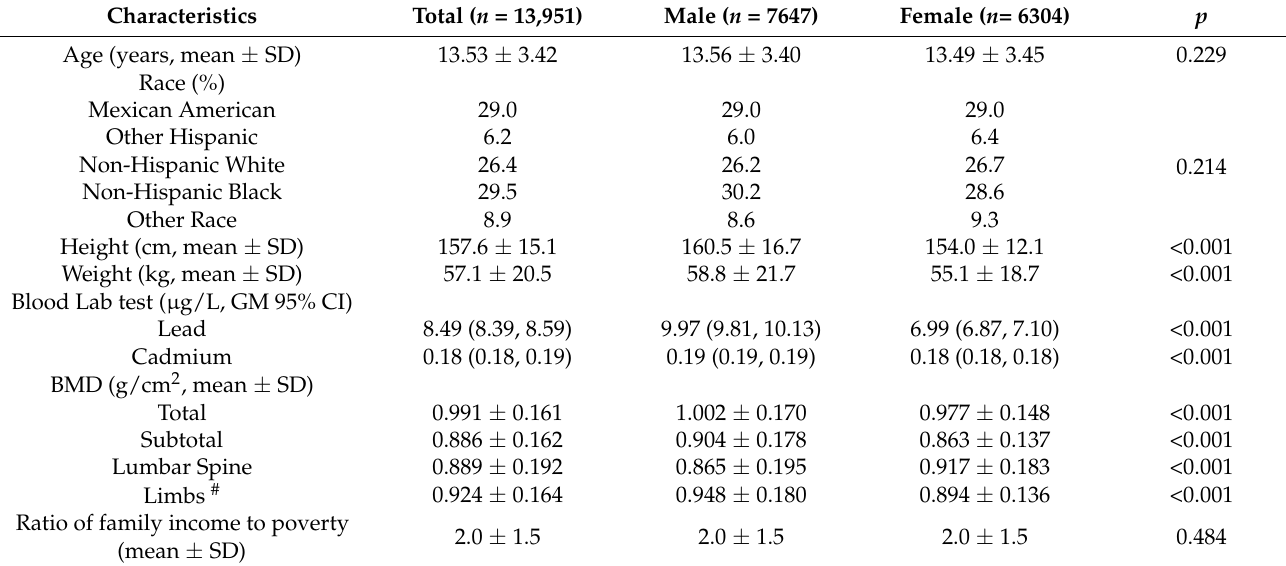
Table 1. Characteristics of included participants